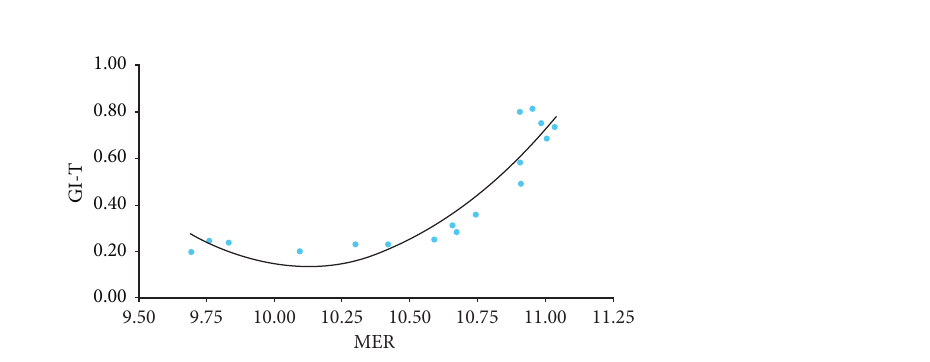
Figure 5: Curve fitting relationship between MER and GI-T.